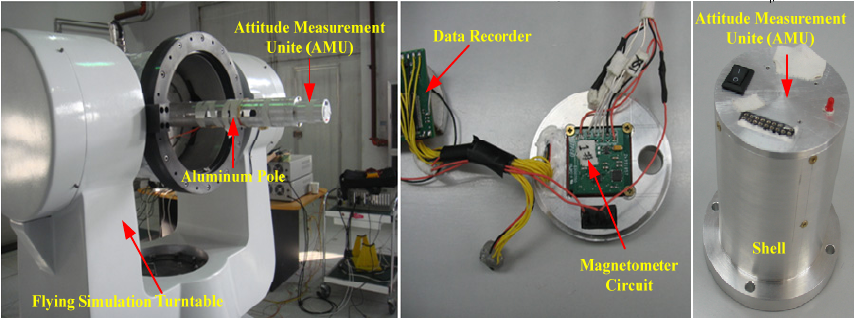
Figure 18. Semi-physical experimental Figure 18 . Semi-physical experimental system.